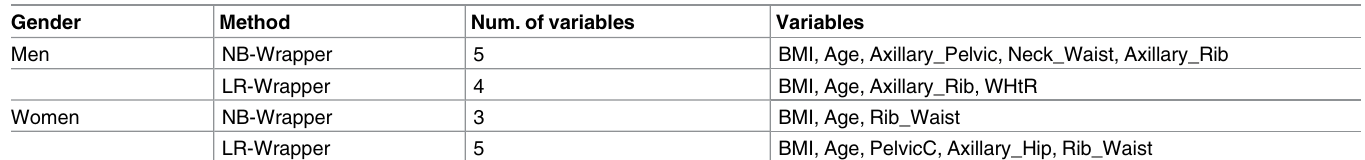
Table 5. Variables selected using the variable selection technique for each model.